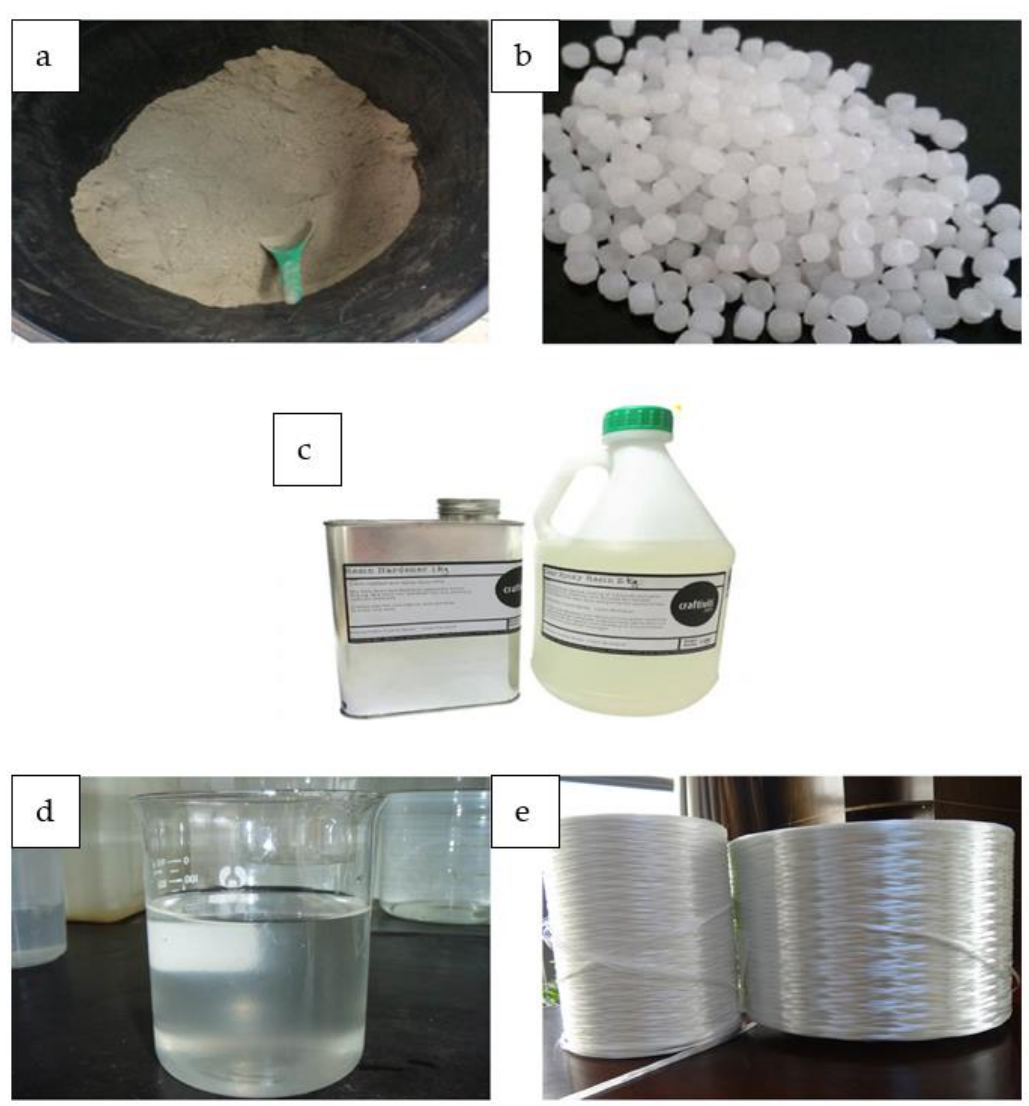
Figure 1. Starting materials. ( a ) High calcium pozzolanic, ( b ) sodium hydroxide pellet, ( c ) epoxy resin (DGEBA) and epoxy hardener (IPDA), ( d ) sodium silicate liquid, and ( e ) fiber glass type